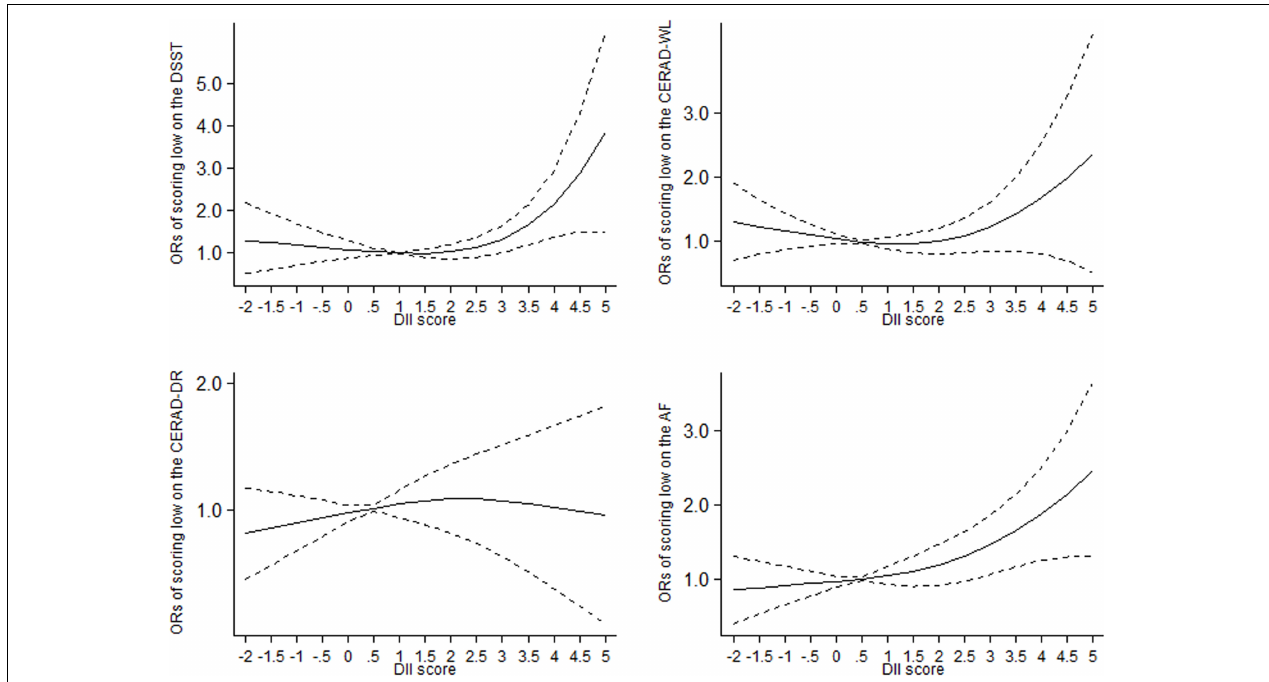
FIGURE 1 | Dose-response relationships between dietary inflammatory index (DII) and the odds of scoring low on the DSST, CERAD-DR, CERAD-WL and AF in older adults, respectively. The middle solid line represents the estimated odds ratio, and the upper and lower short-dash line represents its 95% confidence interval. DSST: Digit Symbol Substitution Test. CERAD-WL: the Consortium to Establish a Registry for Alzheimer’s Disease Word Learning, CERAD-DR: the Consortium to Establish a Registry for Alzheimer’s Disease Delayed Recall, AF: the Animal